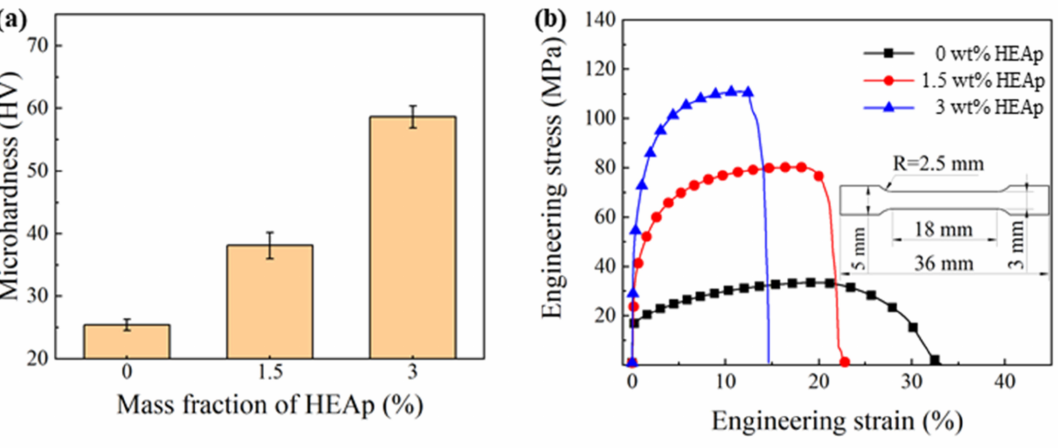
Figure 3. Mechanical properties of the composites in the initial state. ( a ) Vickers microhardness. ( b ) stress–strain curves.